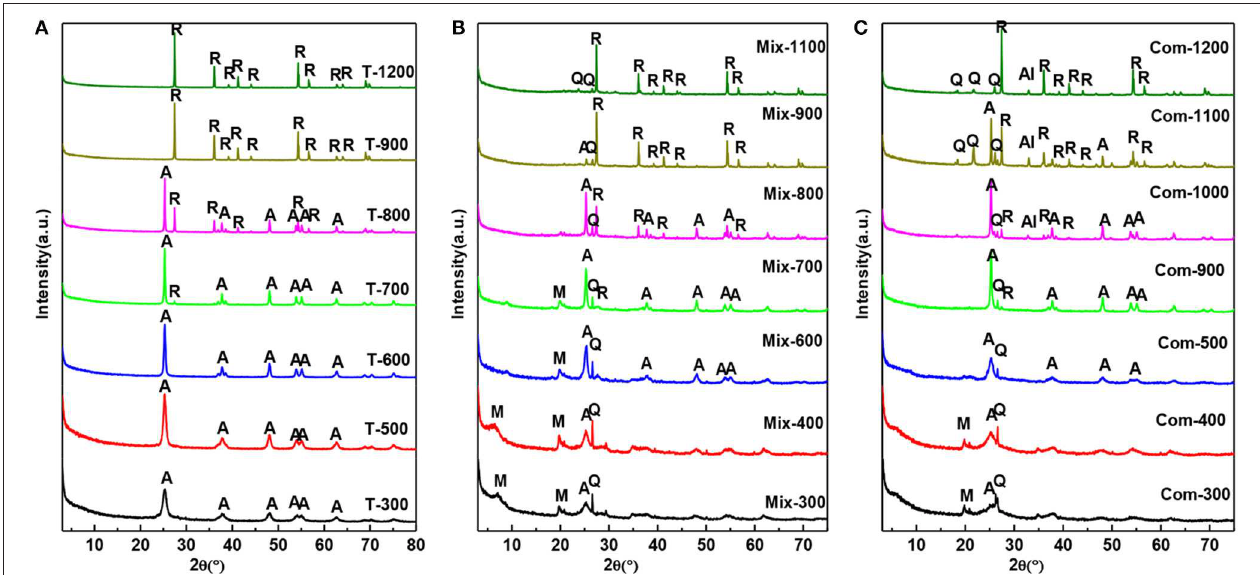
FIGURE 2 | XRD patterns of the (A) T, (B) Mix, and (C) Com calcinated at the different temperatures (M, montmorillonite; Q, quartz; A, anatase; R, rutile; Al, Al 2 TiO 5 ).